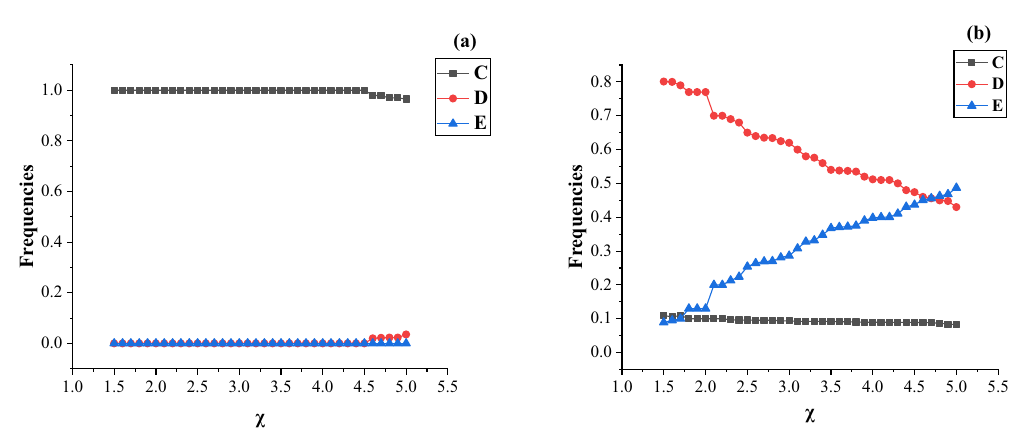
Figure 7. Frequencies of cooperation (C), defection (D), and extortion (E) as functions of extortion factor χ for different value of benefit factor b = 1.2 and b = 2.4 . In the simulations, the game parameters are m 1 = 2, and c = 1